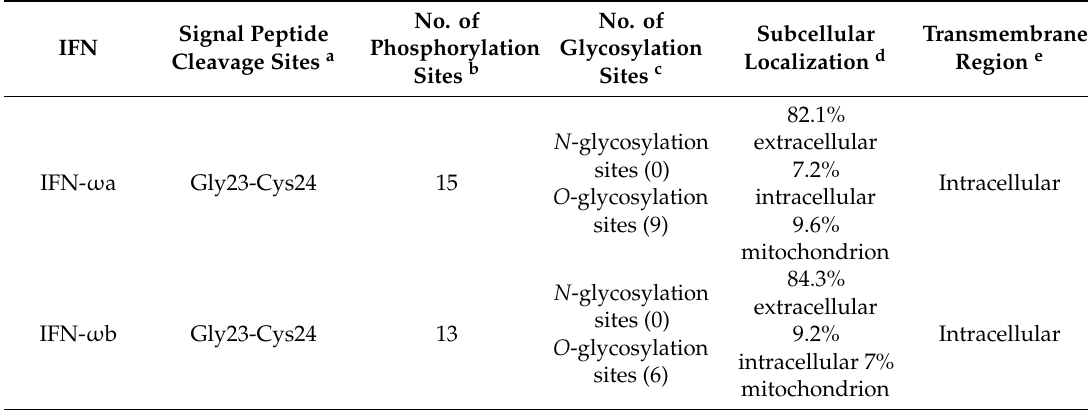
Table 1. Bioinformatics analysis for the two novel feline interferon omega (feIFN- ω ) proteins. Signal Peptide IFN Cleavage Sites a IFN- ω a Gly23-Cys24 15 IFN- ω b Gly23-Cys24 13